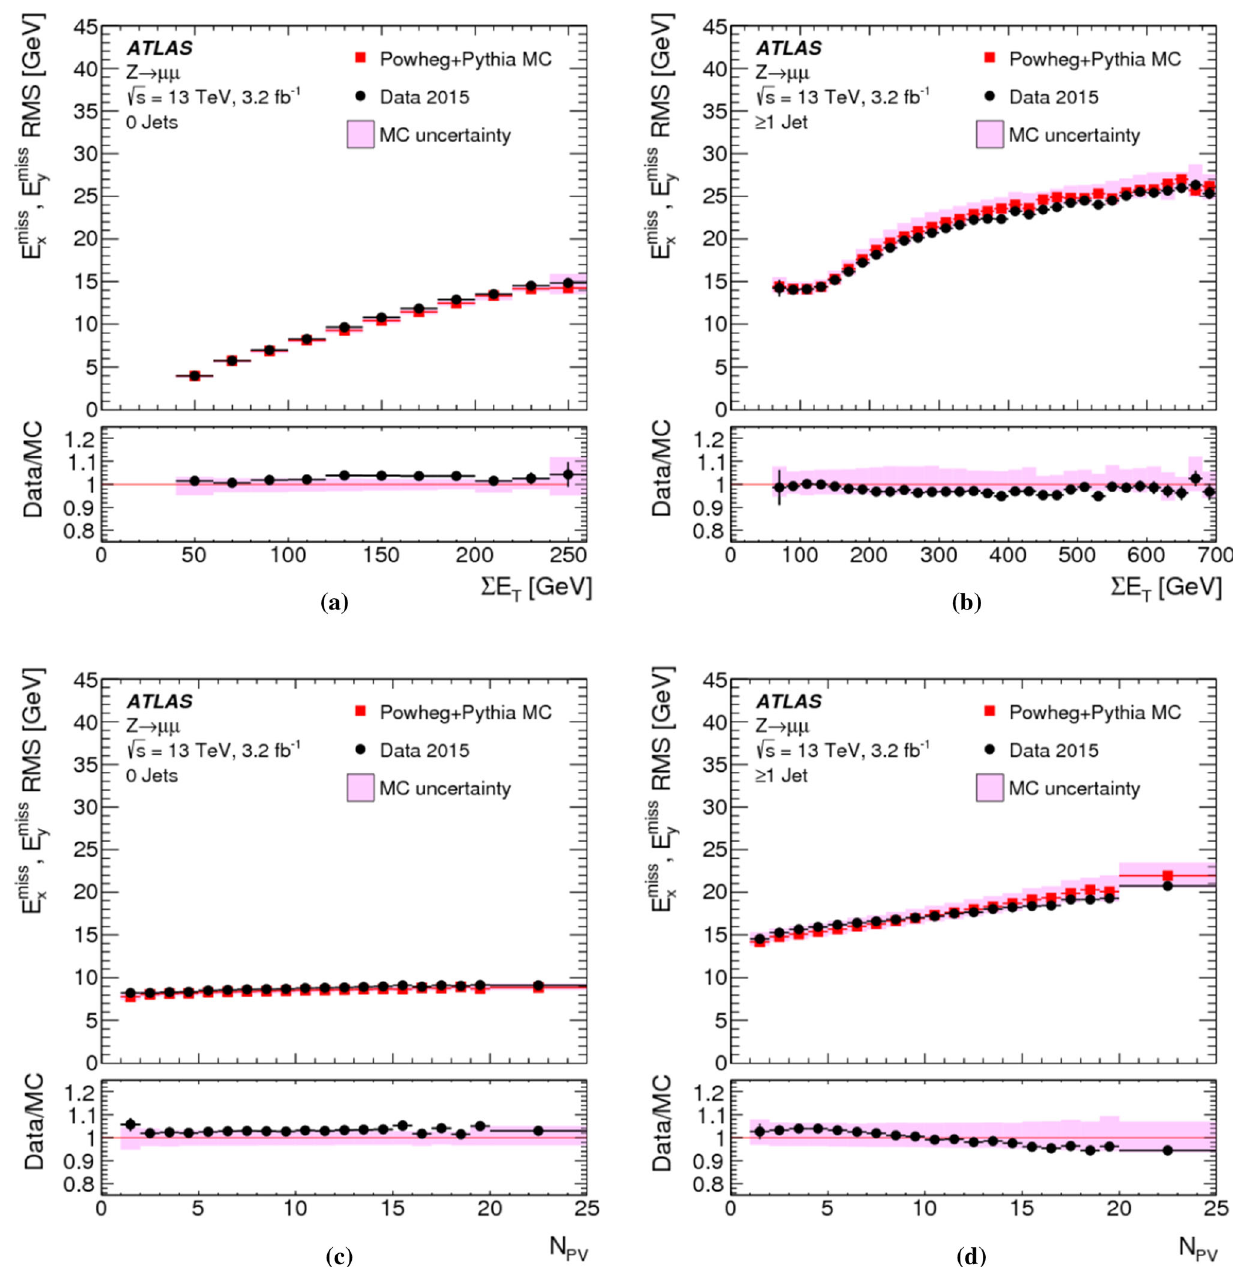
Fig. 8 The E miss RMS miss resolution RMS miss determined for a an exclusive on the pile-up activity, as measured by N PV , for these two T x ( y ) x ( y ) Z → μμ sample without jets with p T > 20GeV ( N jet = 0) and for b samples is shown in c and d , respectively. The shaded bands indicate the combined statistical and systematic uncertainties associated with an exclusive sample with at least one jet above this threshold ( N jet ≥ 1), as a function of (cid:10) E T in data and MC simulations. The dependence of the measurement